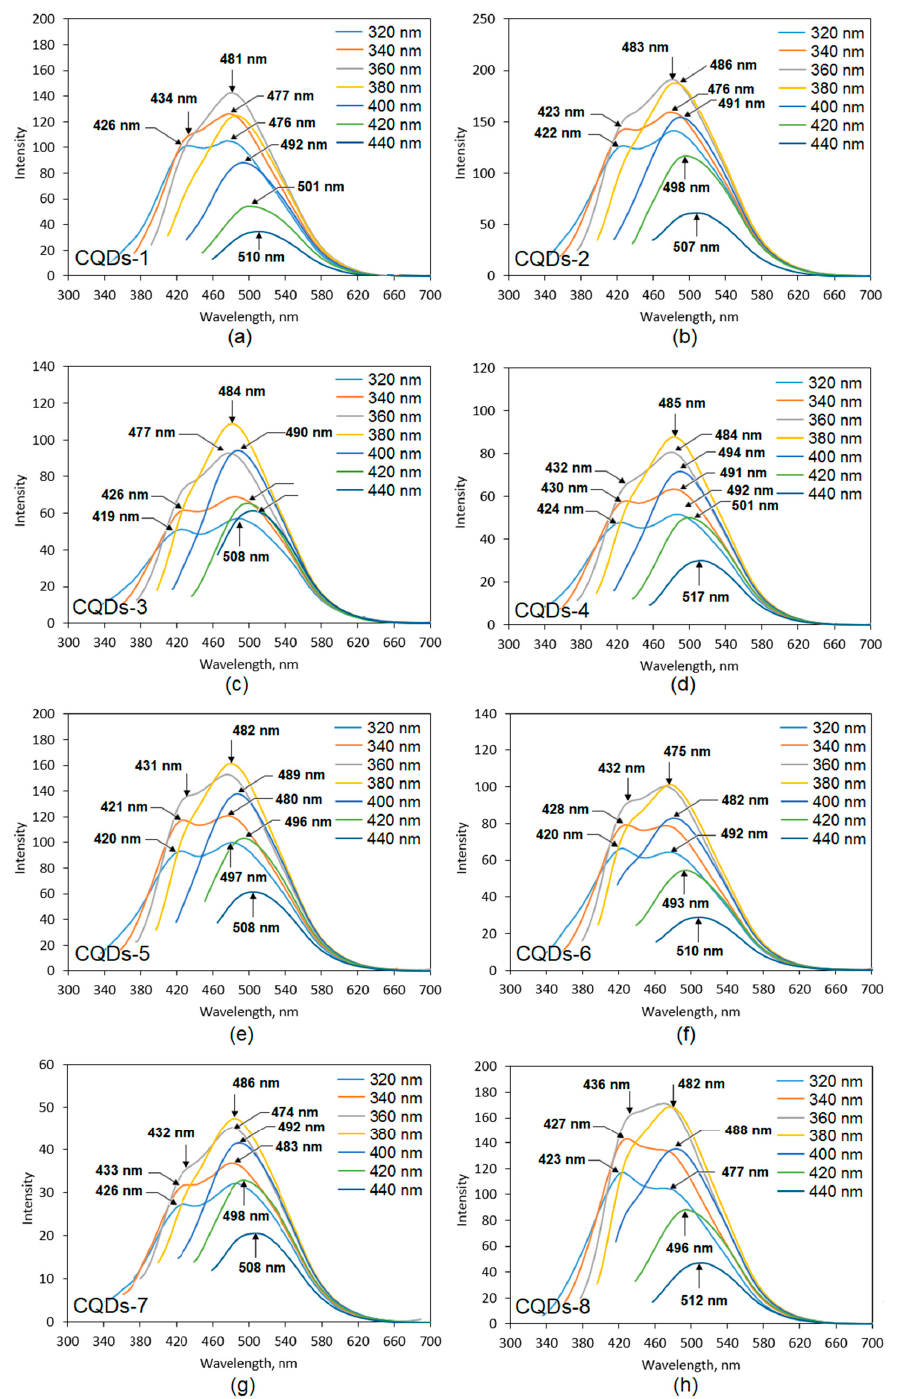
Figure 6. Fluorescence spectra of the prepared samples: ( a )—CQDs-1; ( b )—CQDs-2; ( c )—CQDs-3; ( d )—CQDs-4; ( e )—CQDs-5; ( f )—CQDs-6; ( g )—CQDs-7 and ( h